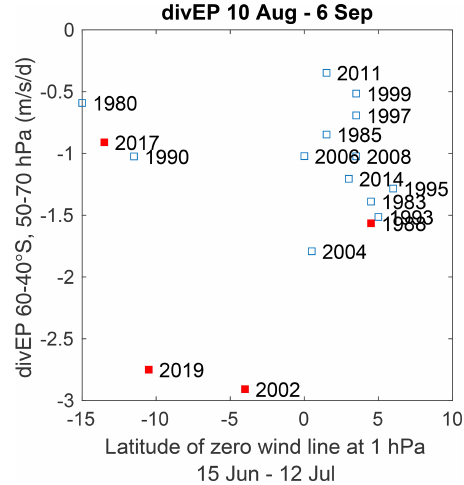
Figure 8. The same as Fig. 7c, but the mean EP flux divergence is now for 10 August–6